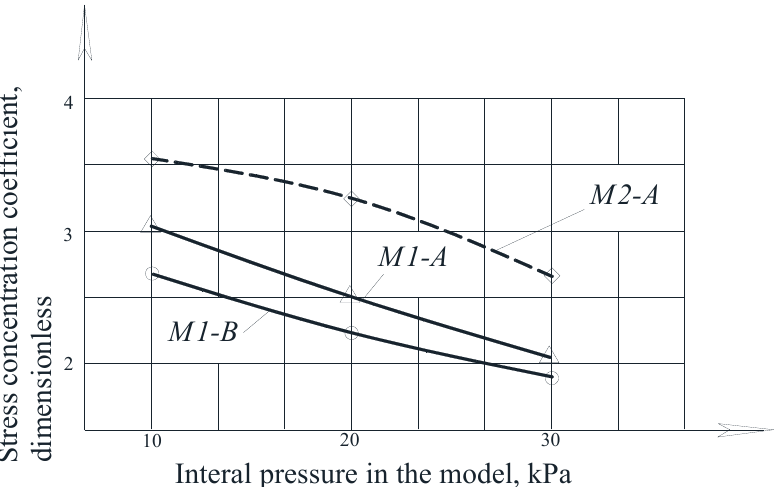
Figure 13. Dependence of the stress concentration coefficient in the dent zone on the internal pressure in the model [33,34].